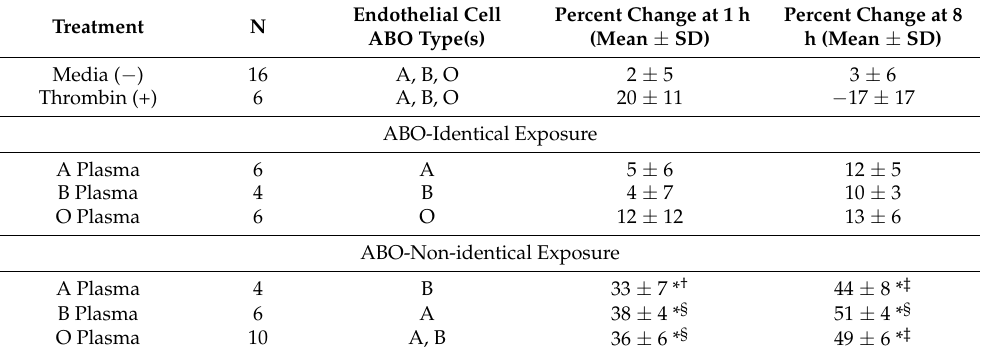
Table 1. Percent change in TEER of HPAEC over 8 h after exposure to matched and mismatched concentrated ABO plasma as compared to media and thrombin. ABO-matched vs unmatched plasma were also compared statistically. Data shown in mean ± SD.